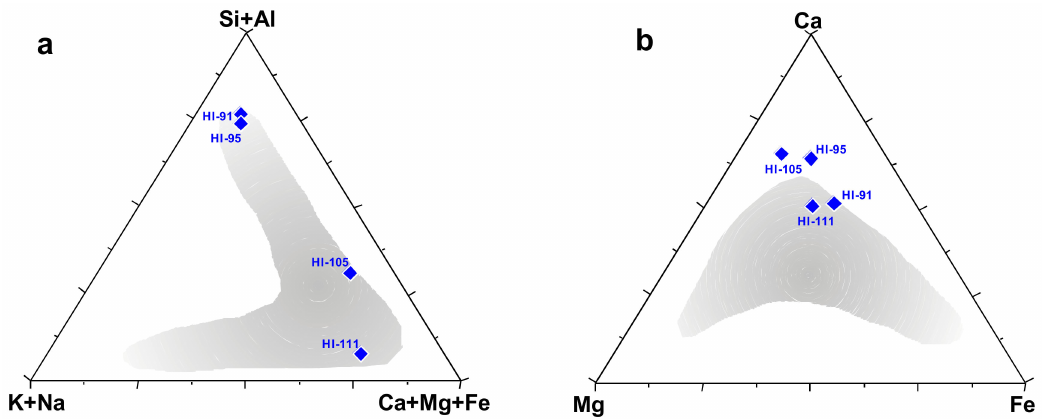
Figure 2. Compositional variations (EDS, mol %) of microinclusion in diamonds from placers in the northeastern Siberian craton, as compared with microinclusions in the diamonds from other worldwide localities (shaded areas). ( a ) (K + Na) − (Si + Al) − (Ca + Mg + Fe) triangle plot; ( b ) Mg − Ca − Fe triangle